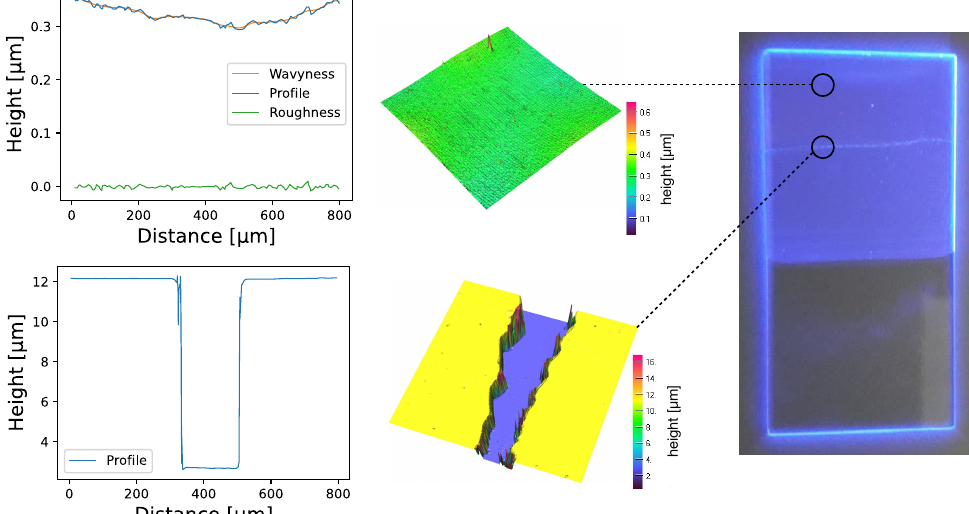
Figure 7. Profilometer measurements of two different paths on a slide coated with the wavelength shifter are shown. In each row, the measured profile is shown on the left, and a three-dimensional profile is shown in the middle. The path in the bottom row comprises a scratch in order to measure the thickness of the coating. A photograph of this slide is shown on the far right, in which the approximate measurement points are